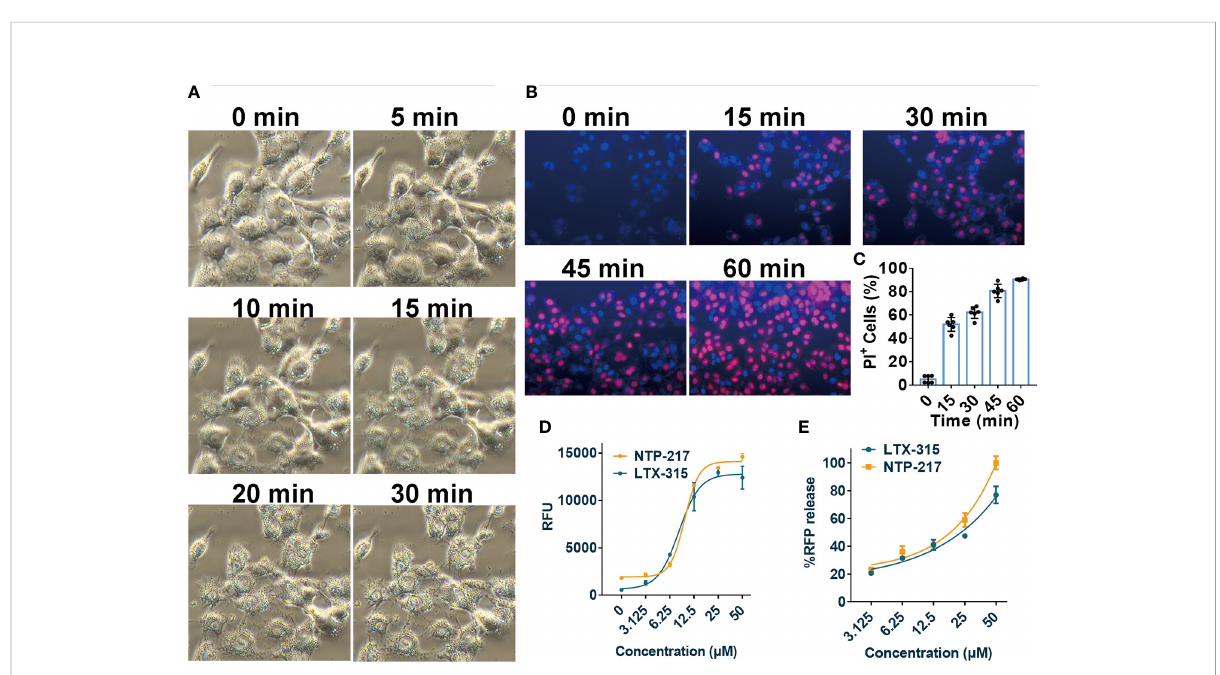
FIGURE 4 Induction of rapid necrosis of liver cancer cells by NTP-217. (A) Morphological changes of Hepa 1-6 cells after incubation with NTP-217 (25 m M) for different lengths of time (objective magni fi cation, x20). (B) PI/Hoechst co-staining shows the loss of membrane integrity in 25 m M NTP-217- treated Hepa 1-6 cells (objective magni fi cation, x10). (C) Quanti fi cation of PI-positive cells in panel B (n=6). The results are presented as the mean ± SD. (D) Levels of leaked ATP from Hepa 1-6 cells subjected to treatment with various concentrations of NTP-217 or LTX-315 for 4 h (n=3). (E) Fluorescent intensities of leaked RFP from Hep3B-Luc2-tdT cells subjected to treatment with various concentrations of NTP-217 or LTX-315 for 0.5 h (n=3). PI, propidium